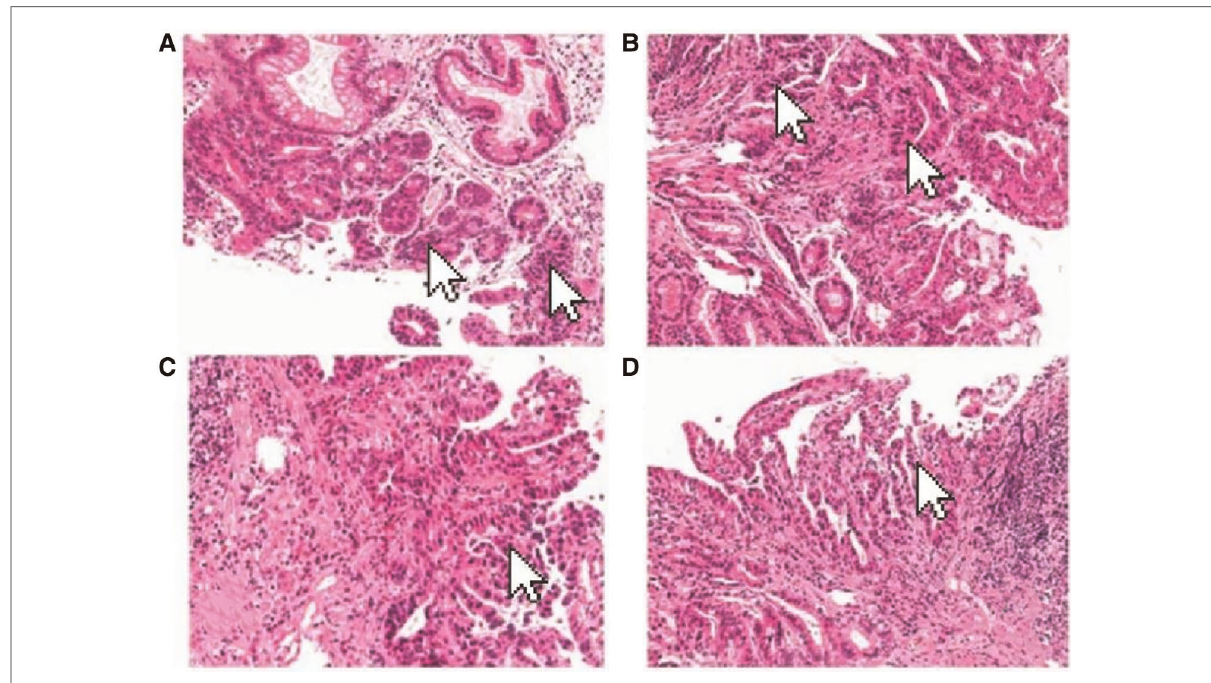
FIGURE 2 Pathological examination of the specimen taken under gastroscopy revealed high-grade intraepithelial neoplasia in the (sinus) mucosal glands (arrow). (HE×100).